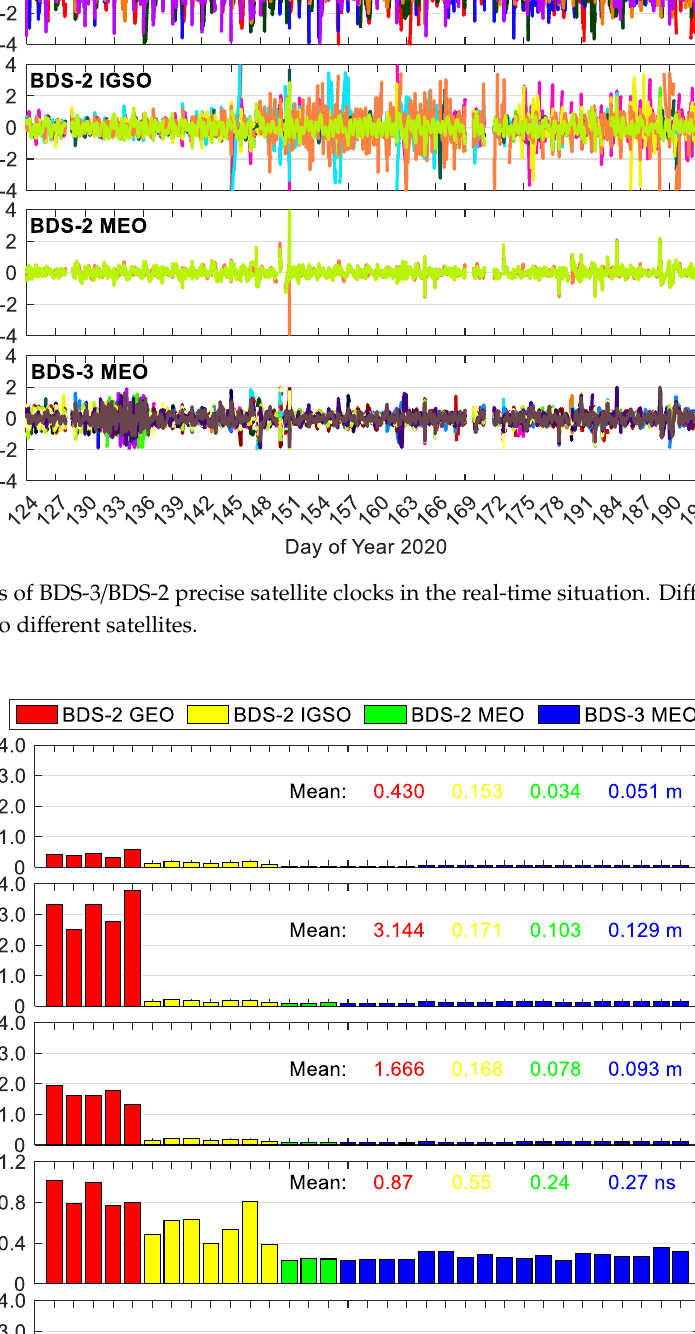
Figure 10. Cross-track errors of BDS-3/BDS-2 precise satellite orbits in the real-time situation. Different colors in the figure refer to different satellites.